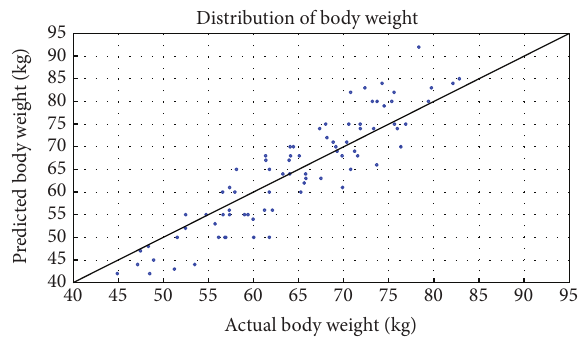
Figure 12: Plot of actual against estimated body weight attained at 27